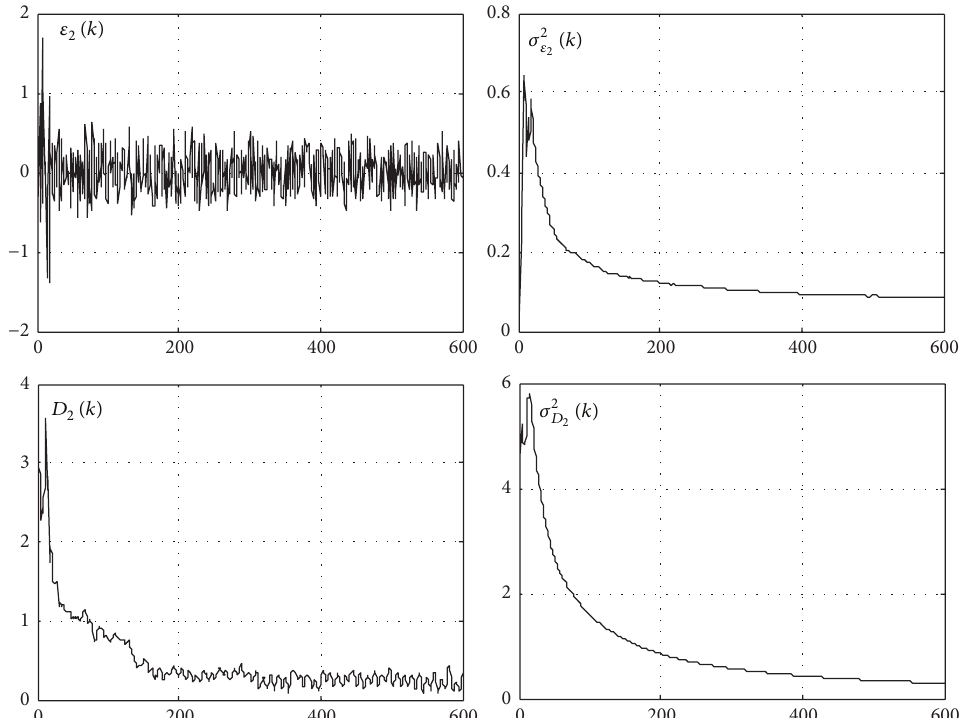
(𝑘) and 𝜎 2 (𝑘) 𝐷 2 2